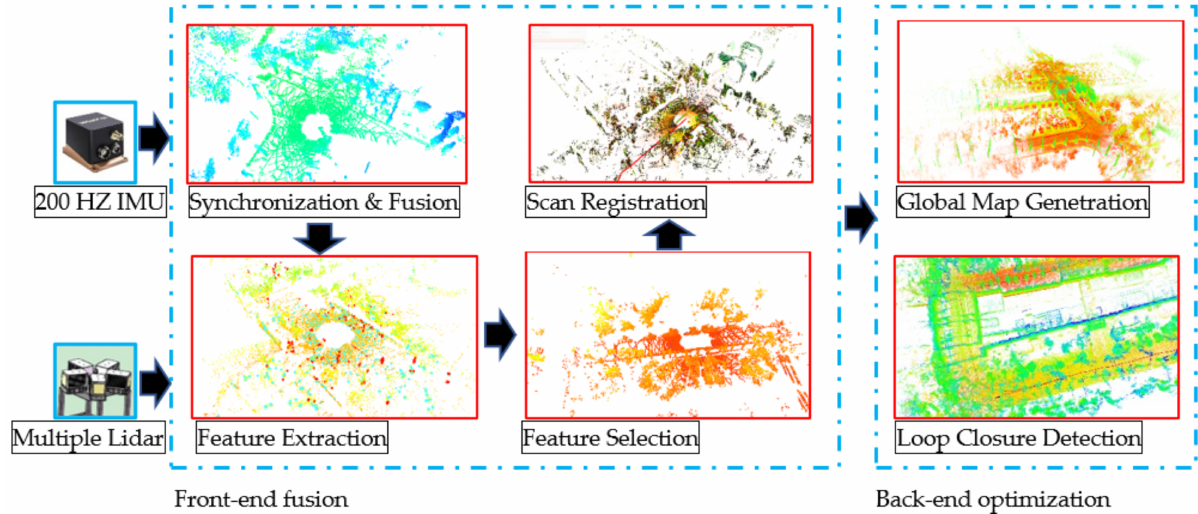
Figure 1. Overview of multi-lidar based mapping and odometry